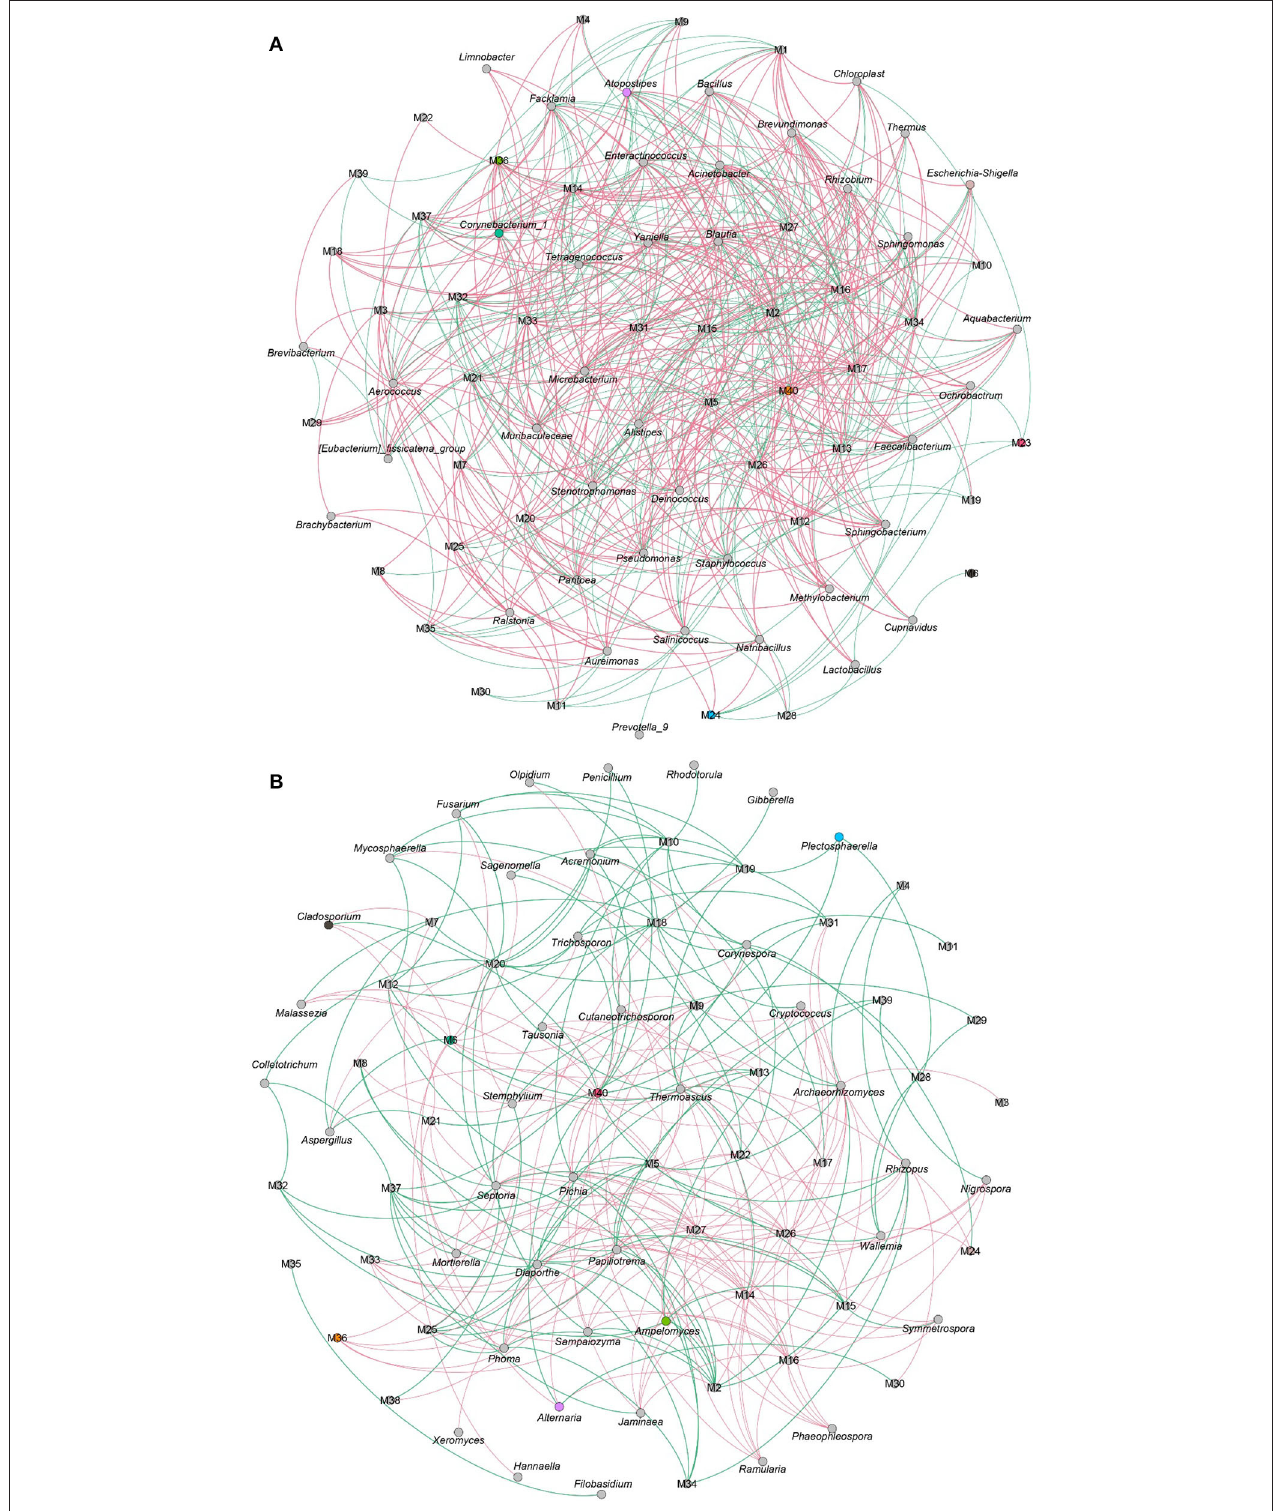
FIGURE 10 | The correlation between microbial community and volatile flavor compounds. Co-occurrence networks of representative bacterial taxa and core volatile flavor compounds. Green line means negative correlation; red line means positive correlation (A) . Co-occurrence networks of representative fungal taxa and core volatile flavor compounds. Green line means positive correlation; red line means negative correlation (B)